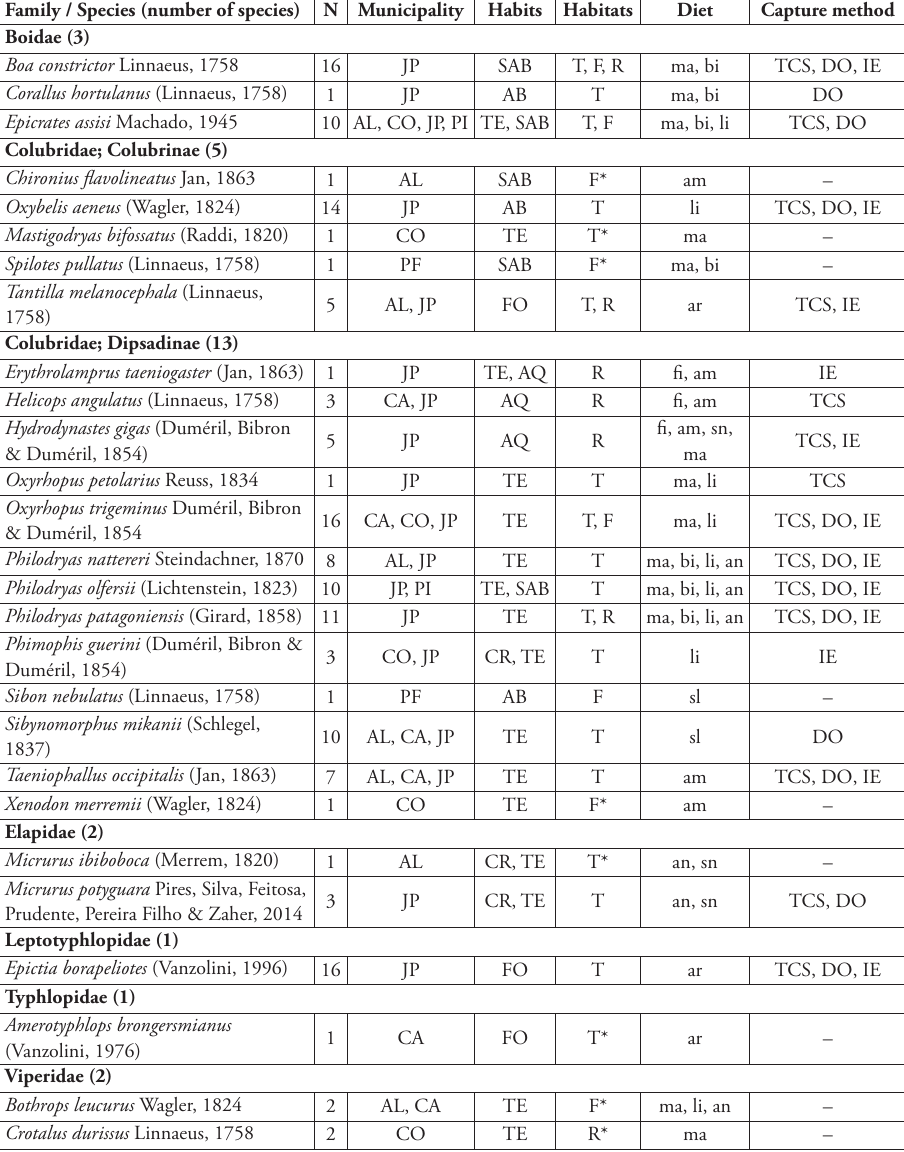
Table 1. Summary of the Information of Natural History of the Snakes in Barra de Gramame. Abbre- viations of Municipalities are: AL = Alhandra; CA = Caaporã; CO = Conde; JP = João Pessoa (Barra de Gramame), PF = Pedras de Fogo, PI = Pitimbu. Habits are: AB = arboreal, AQ = aquatic, CR = cryptozoic, FO = fossorial, TE = terrestrial, SAB = semi-arboreal. Habitats are: T = tabuleiro, F = forest, R = restinga, * = Data from Herpetological Collection. Diet are: am = amphibians, an = anfisbaenas, ar = arthropods, bi = birds, fi = fishes, li = lizards, ma = mammals, sl = snails, sn = snakes. Capture Methods are: TCS = time-constrained search, DO = donated, IE = incidental encounters; – = No data available (see methods). Family / Species (number of species) N Municipality Habits